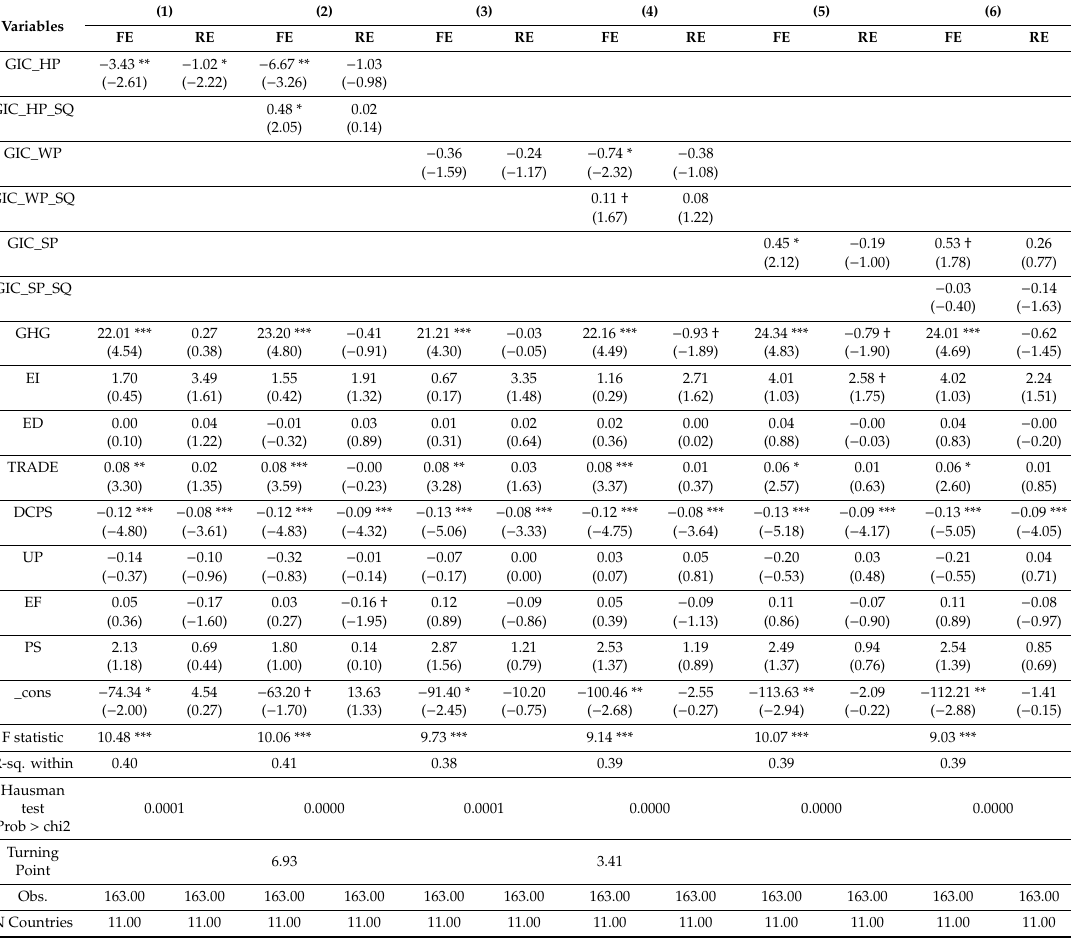
Table 6. Panel data regression models towards the influence of hydro power, wind power and solar photovoltaic on economic